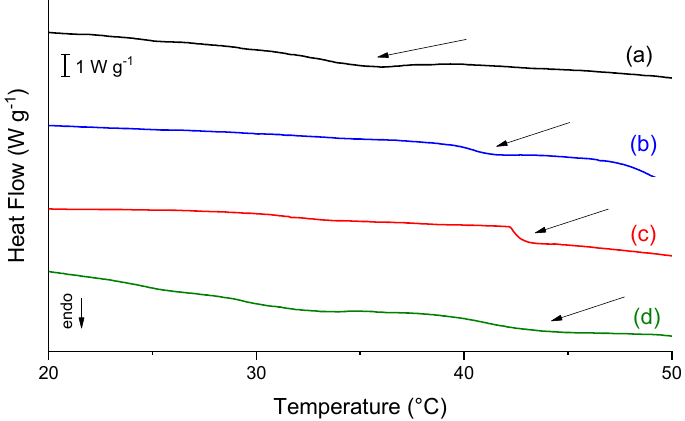
Figure 5. DSC curves of the scaffolds. In (a) C; (b) CP; (c) C10P; and (d) C30P.